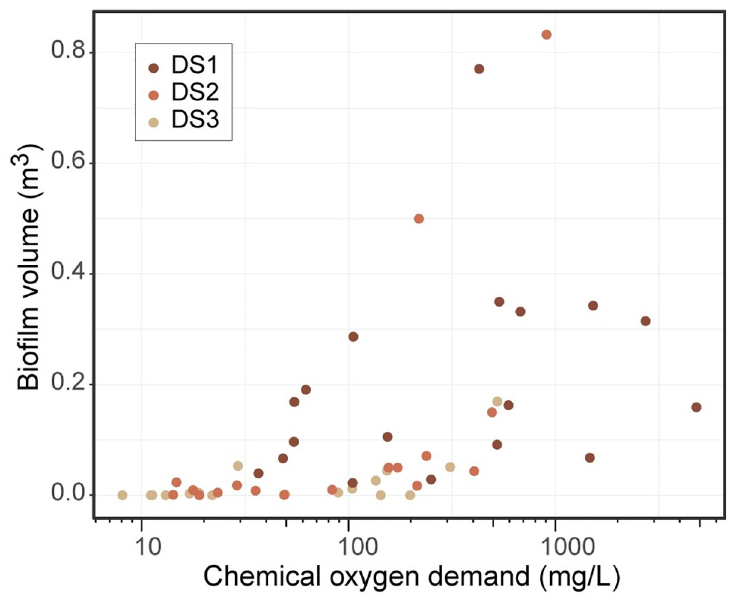
Fig 4. Comparison of mean 2-week flow-weighted chemical oxygen demand (COD) concentrations and associated biofilm volume measurements.